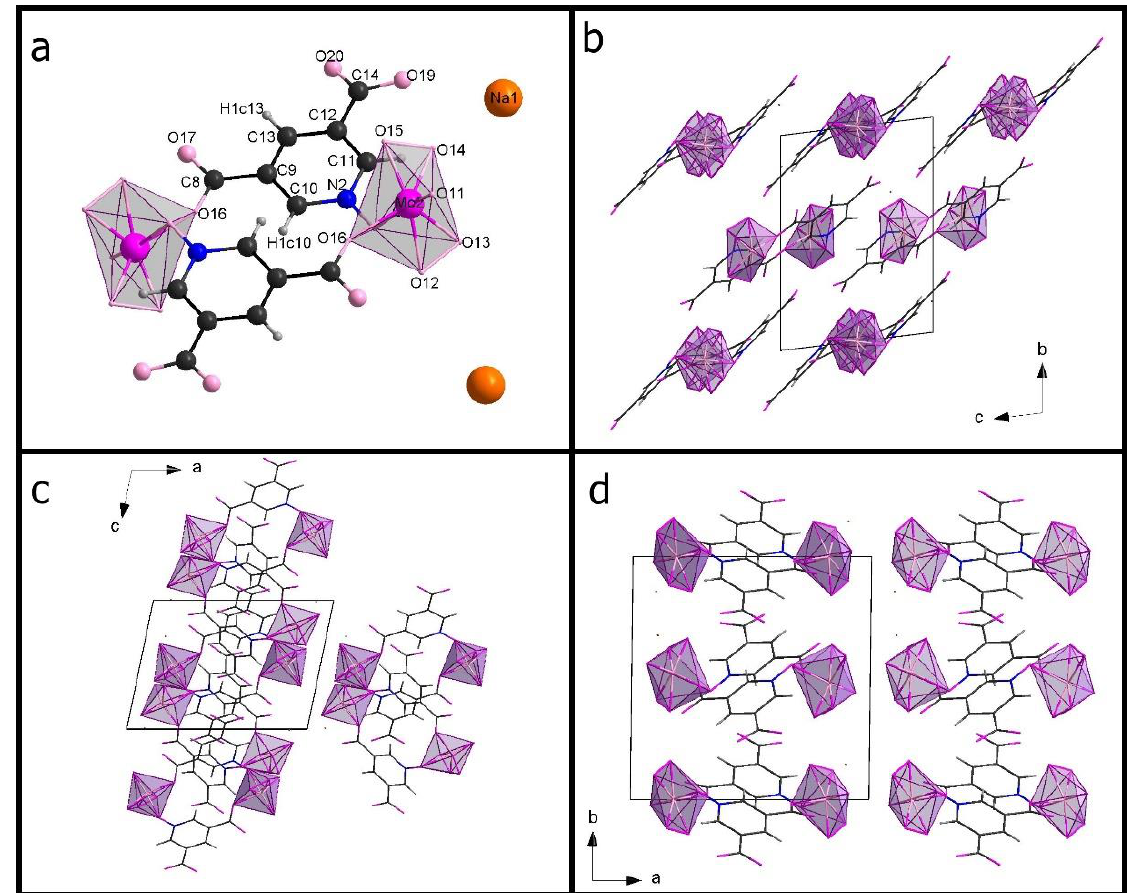
Figure 1. One of two centrosymmetric dimers in the asymmetric unit of Na-35dcpa ( a ); packing diagram of Na-35dcpa along the a-axis ( b ), along the b-axis ( c ), along the c-axis ( d ). The first compound Na-35dcpa contains dimeric anions, where organic and inorganic groups are connected by two oxygen atoms. The linking oxygen atom belongs to carboxylic group C-O (1.28 (4) Å), O-Mo (2.06 (2) Å) and N-oxide group N-O (1.30 (2) Å), O-Mo (1.95 (1) Å). The central molybdenum atom is surrounded by seven oxygen atoms forming pentagonal bipyramid (MoO 7 ). Two peroxo groups are observed in each MoO 7 unit. The distance between molybdenum atom and one apical terminal oxygen atom (Mo=O) is 1.68 (2) Å. Moreover, the molybdenum atom is shifted from the equatorial plane of the pentagonal bipyramid by 0.403 (6) Å. The equatorial plane and the plane based on aromatic ring is twisted by 42.9 (5) ◦ angle. In the structure, there are two independent anions